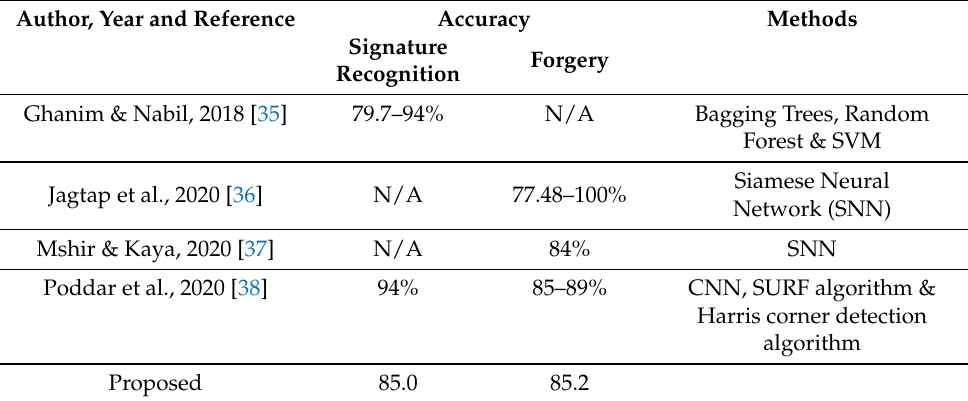
Table 4. Comparison of similar